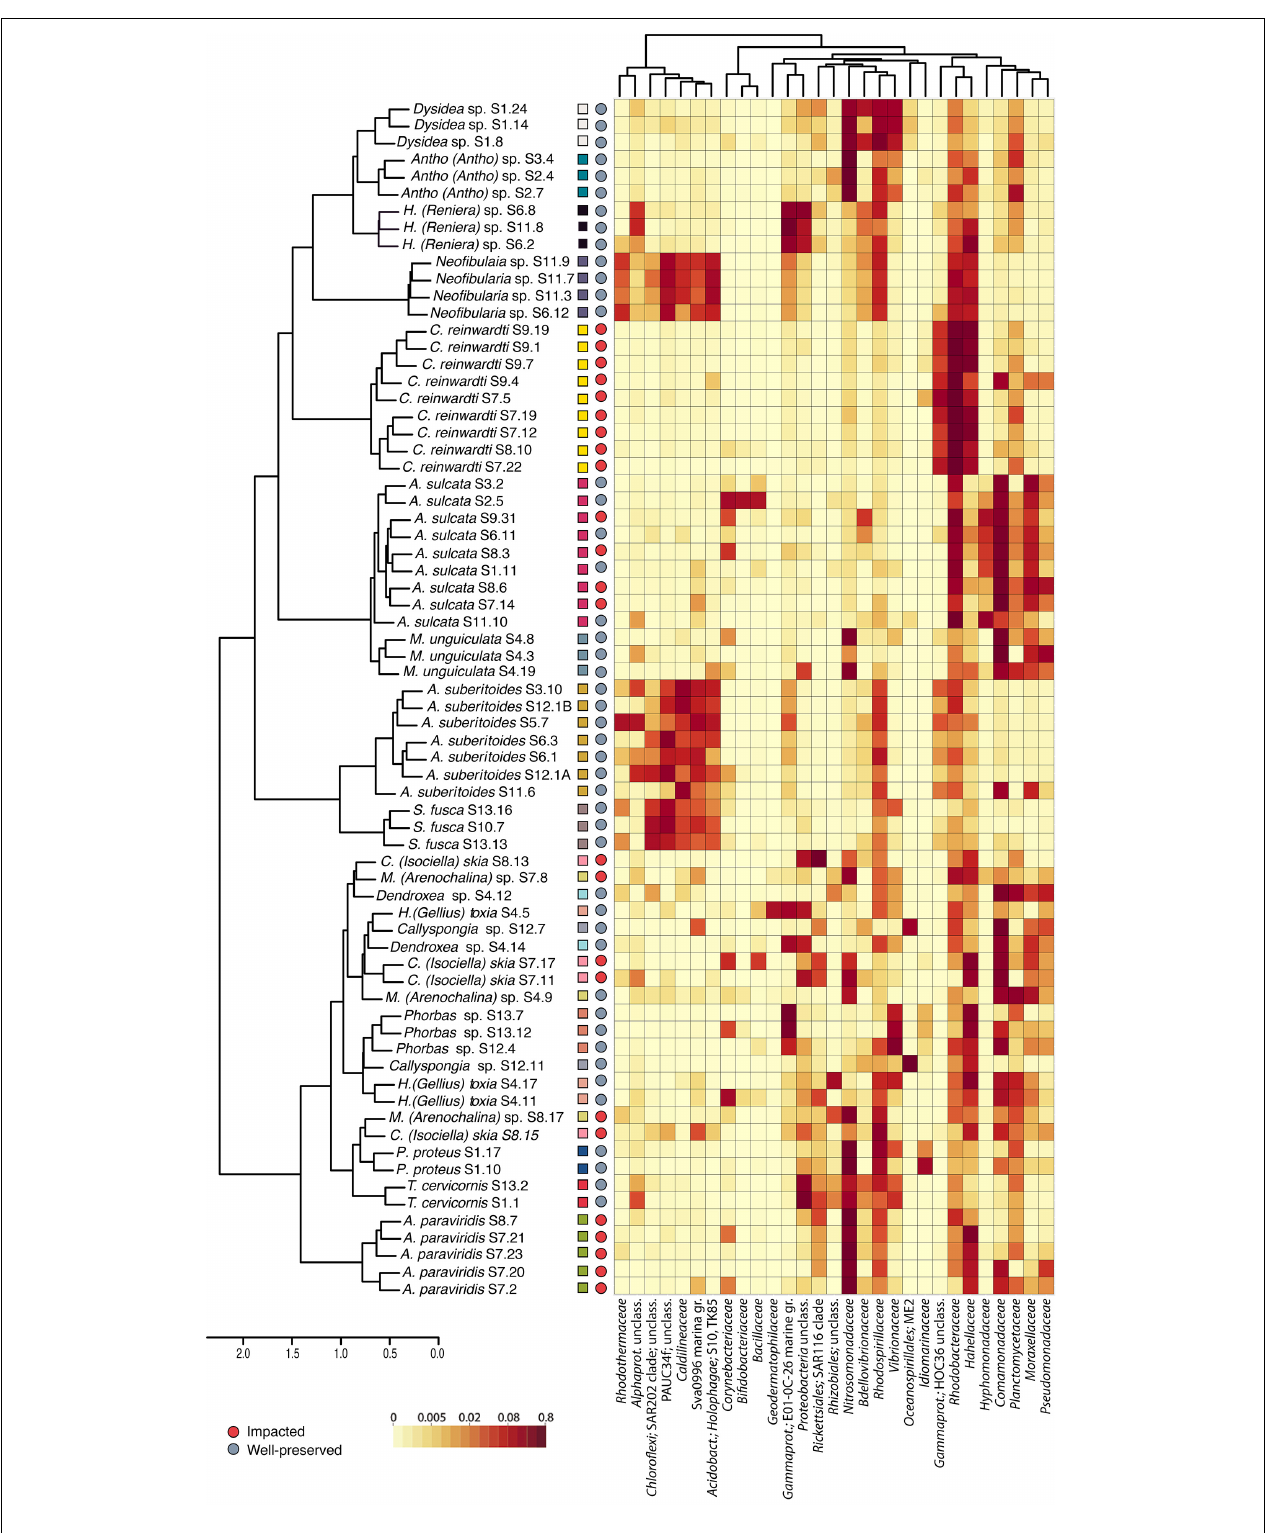
FIGURE 3 | Heatmap of the sponge bacterial composition at the family level. Only taxa with relative abundances higher than 1% in any of the samples are shown, with abundance represented in the color temperature bar. Sponge samples ( y -axis) and bacterial taxa ( x -axis) are organized according to a hierarchical clustering based on Bray-Curtis dissimilarity matrices (at the level of ZOTU and family, respectively). Square colors correspond to different sponge species, and circle colors indicate the site of collection: impacted (red) or well-preserved (gray).